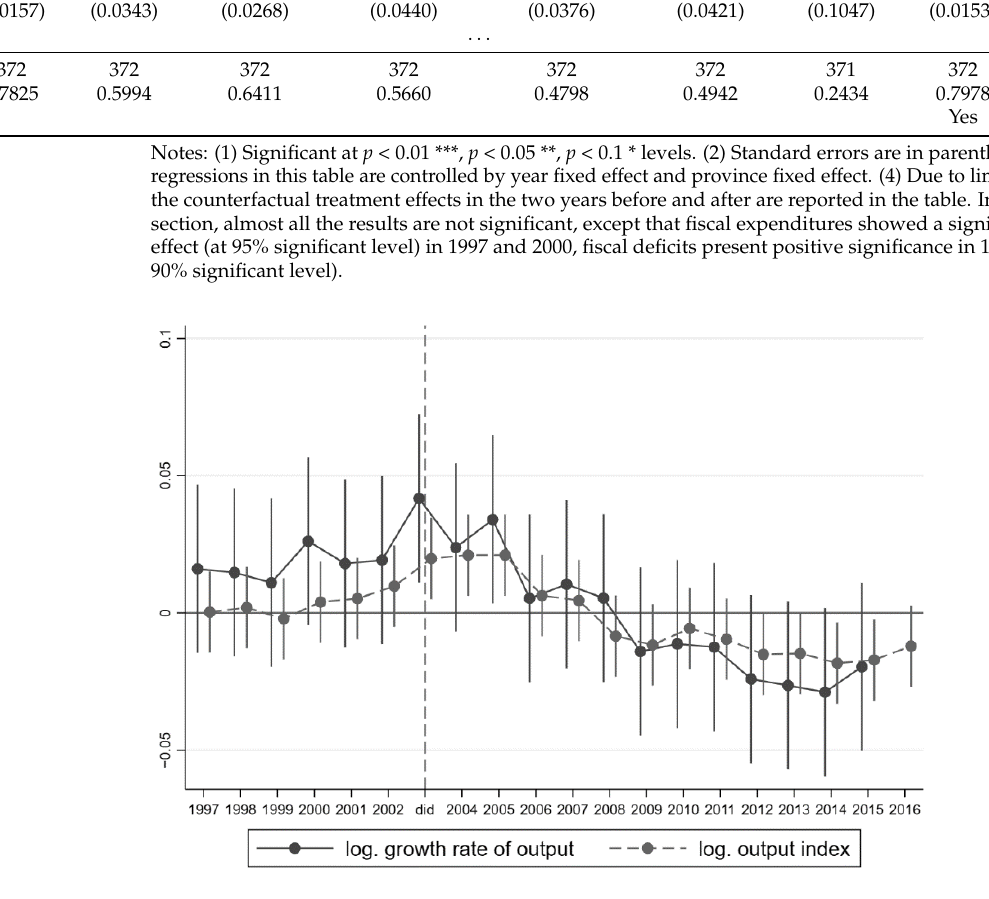
Figure 1. Dynamic Mechanism